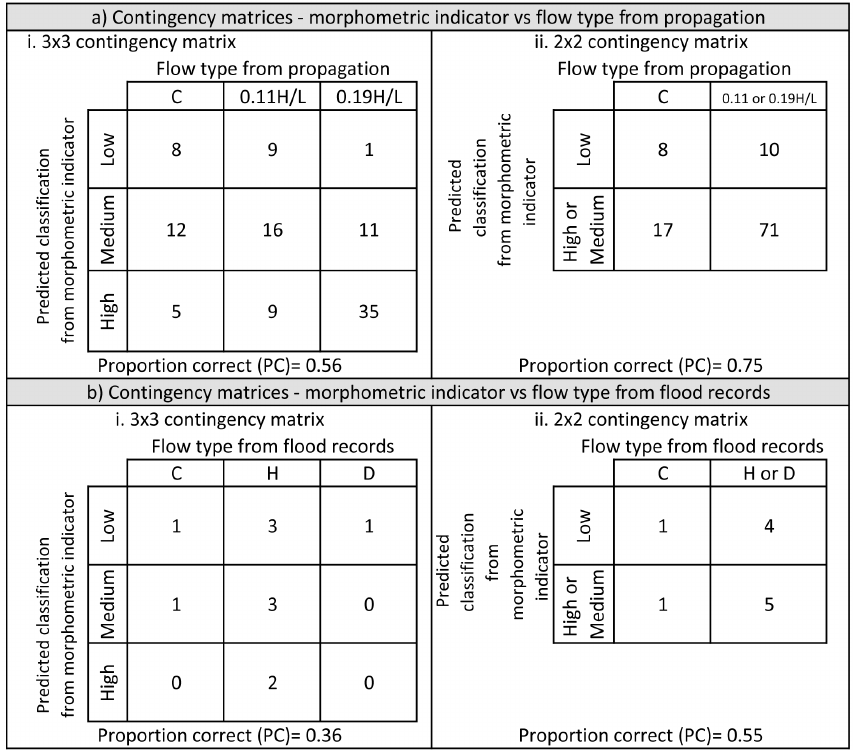
Figure 9. Contingency table to compare the watershed classification according to debris flow propagation capacity from the MSF model and the morphometric indicator, and the flood type classification from available information and the morphometric indicator.